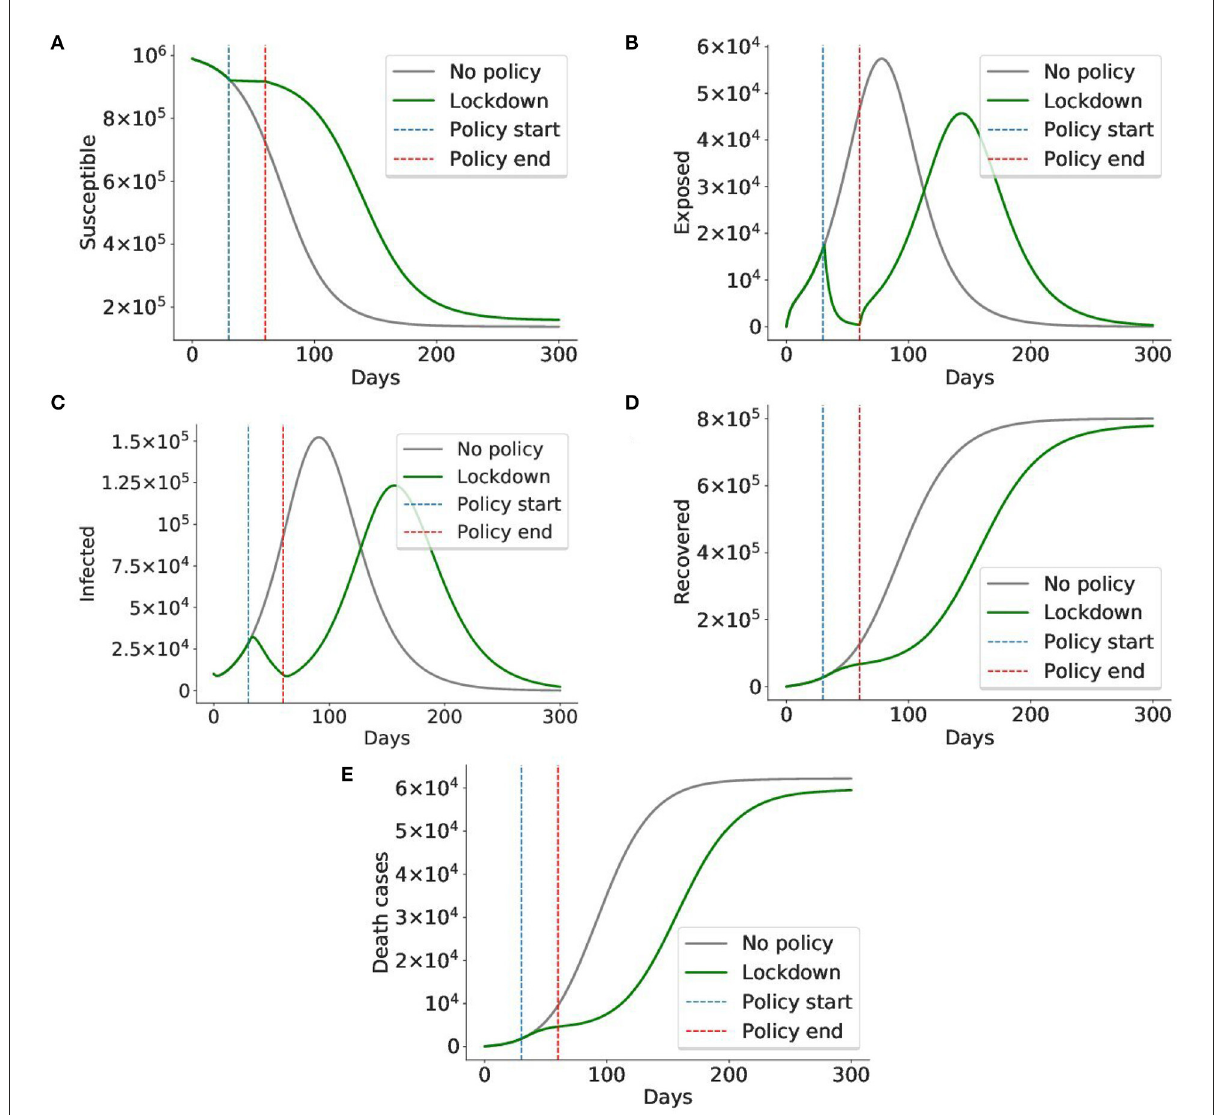
FIGURE14 A lockdown delays the virus spread, but cannot prevent it. In this simulation, the lockdown policy was imposed from day 30 to day 60 (total 1 month). The gray graph represents the baseline situation with no policy applied, the green graph indicates the case when a lockdown is applied. The blue and red lines mark the start and end of the lockdown, respectively. We can see that although lockdown sharply decreases the number of exposed and infected cases, it cannot prevent the virus from spreading after the lockdown is lifted on day 60. The number of exposed and infected cases rises again. Given the cost of the lockdown, it is impossible to maintain it for long periods of time, making it less preferable to less costly policies. Thus, the conclusion is in alignment with those of prior works (42, 46). (A) Susceptible cases, (B) Exposed cases, (C) Infected cases, (D) Recovered cases, (E) Death